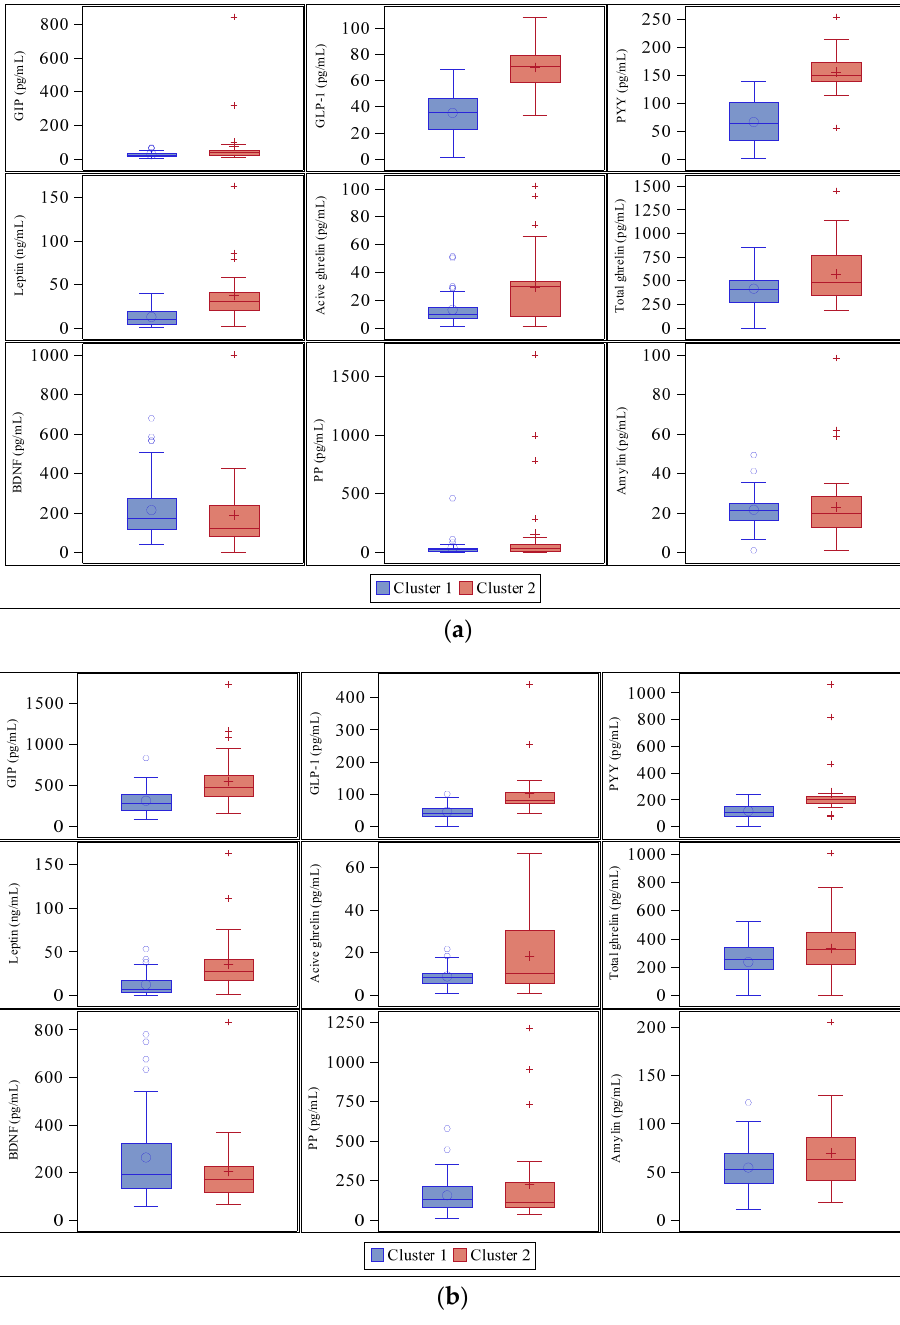
Figure 3. Hormonal concentrations between clusters. Glucose-dependent insulinotropic polypeptide (GIP), Glucagon-like peptide-1 (GLP-1), peptide YY (PYY), plasma brain-derived neurotrophic factor (BDNF), pancreatic polypeptide (PP). ( a ) At fasting. GIP ( p < 0.002), GLP-1 ( p < 0.0001), PYY ( p < 0.0001), leptin ( p < 0.0001) and active ghrelin ( p < 0.04); ( b ) At time 60 ′ . Total and active ghrelin, GIP, GLP ‐ 1, PYY and leptin ( p <0.05). Cluster 1 outliers (o) and cluster 2 outliers (+).